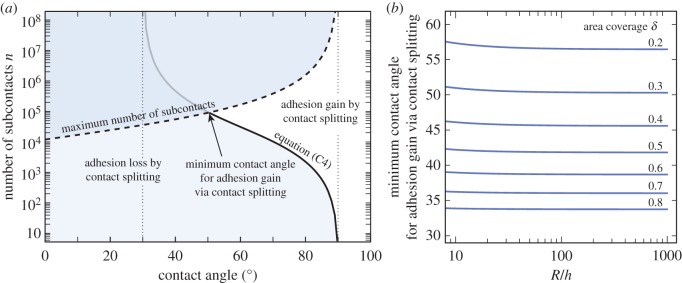
Effect on adhesion if a single meniscus between two flat rigid plates is split into n smaller contacts with a size-invariant fluid film thickness. (a) Contact splitting will always reduce the adhesive force for contact angles ϕ < 30°, and always increase it for 90° < ϕ < 150°. For 30° < ϕ < 90°, the effect of contact splitting will depend on the number of sub-contacts n, the area coverage δ, the ratio R/h between radius and fluid film thickness, as well as on the contact angle ϕ according to equation (C4) (limit indicated by the solid line). If the fluid film thickness is size-invariant, n has an upper limit (indicated by the dashed line), which further restricts any adhesion gain via contact splitting to even larger angles, as indicated by the intersection of the dashed and the solid line. The plot shows the number of sub-contacts required to increase adhesion via contact splitting for δ = 0.3 and R/h = 100. (b) Minimum angle for which an adhesion gain via contact splitting is possible (i.e. the angle where the dashed and the solid lines in (a) intersect), plotted as a function of R/h and δ. (Online version in colour.)